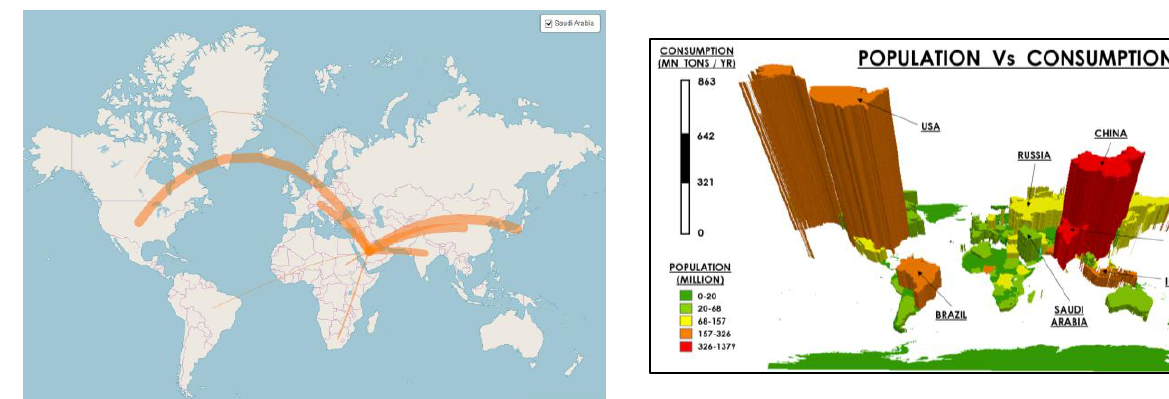
Figure 11. Hybrid map depicting population in colours and consumption of refined products as 3D extrusion.